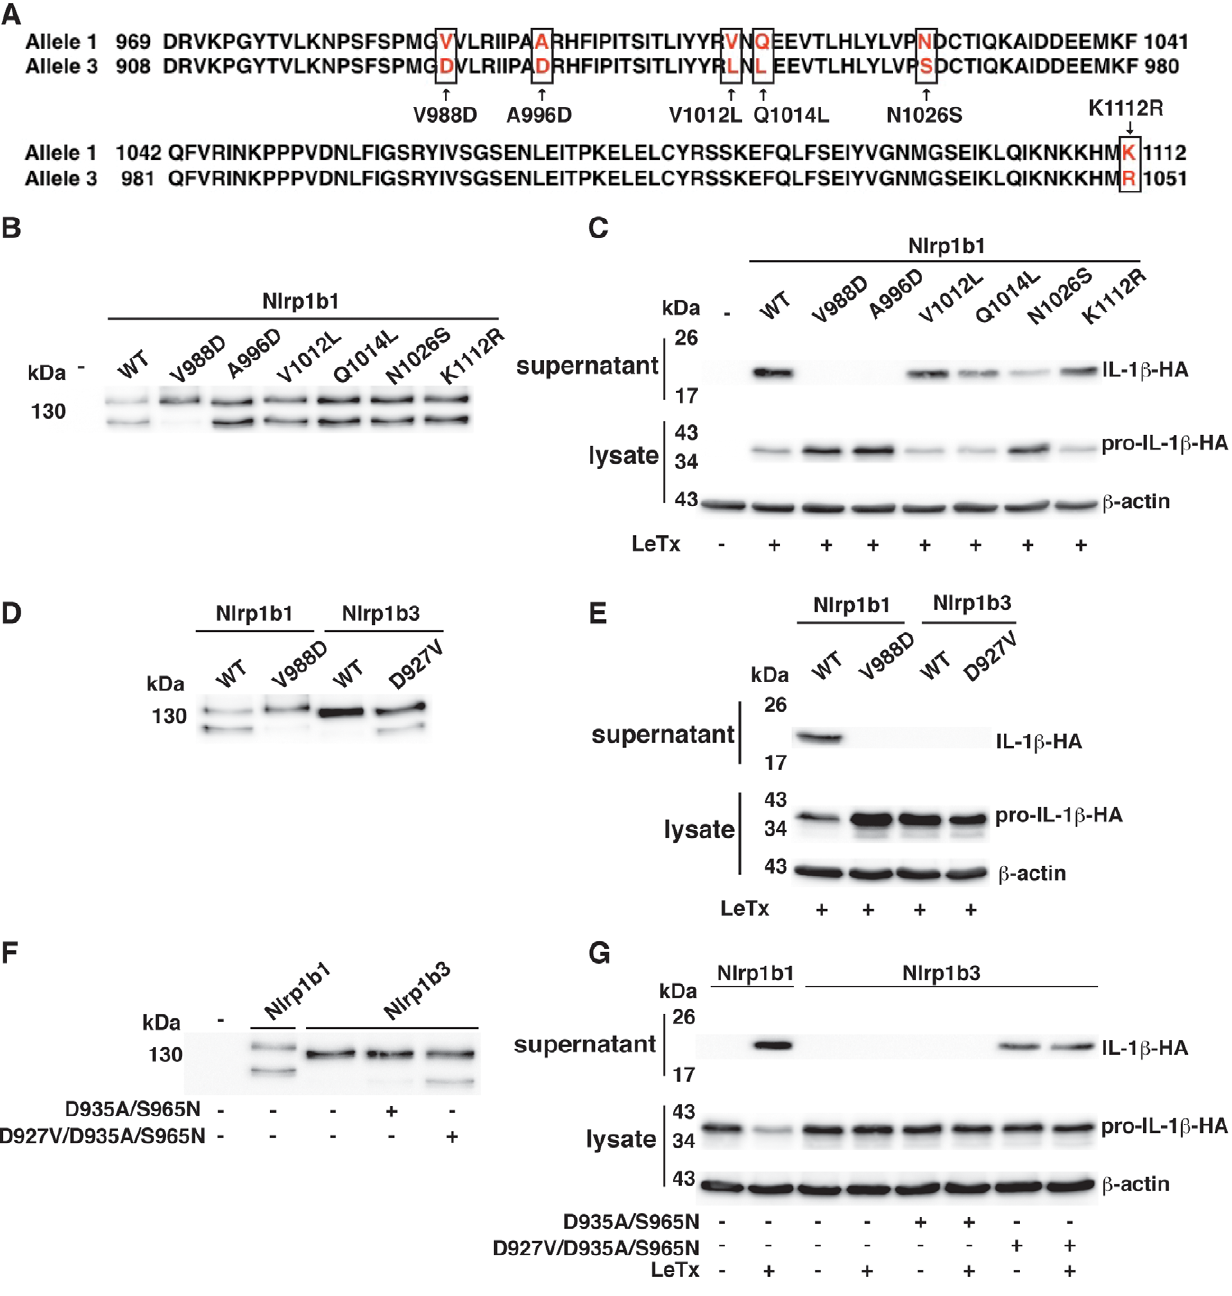
Figure 5. The V988D mutation in Nlrp1b1 eliminates both cleavage and inflammasome activity. (A) Alignment of allele 1 with allele 3 from amino acid 969 to 1112 of Nlrp1b1. Highlighted amino acid differences use numbering from allele 1. (B, D, and F) HT1080 cells were transfected with pNTAP plasmids encoding the indicated Nlrp1b proteins. Approximately 24 h following transfection, cells were lysed and TAP-tagged proteins were precipitated with streptavidin resin and immunoblotted using an Nlrp1b antibody. (C, E, and G) Cells were transfected with pNTAP plasmids encoding the indicated Nlrp1b constructs, as well as with pcDNA3-pro-caspase-1-T7 and pcDNA3-pro-IL-1 b -HA. Approximately 24 h after transfection, cells were treated with LeTx (10 2 8 M LF and 10 2 8 M PA) for 3 h. Cell lysates were collected and probed for HA-tagged pro-IL-1 b and b - actin; cell supernatants were collected and immunoprecipitated with anti-HA antibodies and probed for HA-tagged IL-1 b by immunoblotting. Blots are representative of three independent